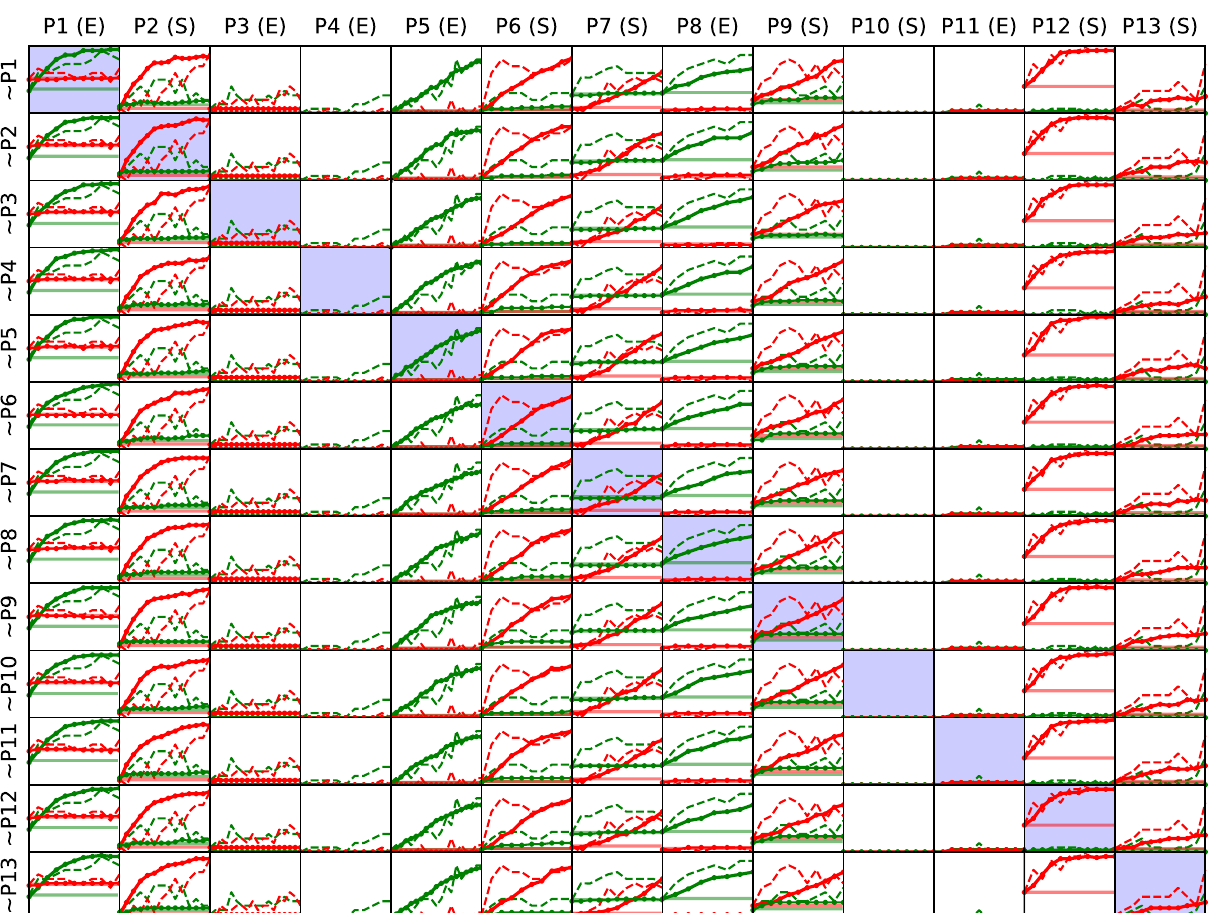
Figure 5. Leave-one-out cross-validation of the BiLex treatment model. Individual plots compare simulated (solid lines) and actual (dashed lines) patient treatment responses in English (green) and Spanish (red). Each row shares the same treatment model, optimized to fit all but one patient. Columns show the responses for each patient, with the treated language ( E English, S Spanish) indicated in the title. Similarity between on- and off- diagonal entries illustrates the model’s ability to predict the treatment responses of previously unseen